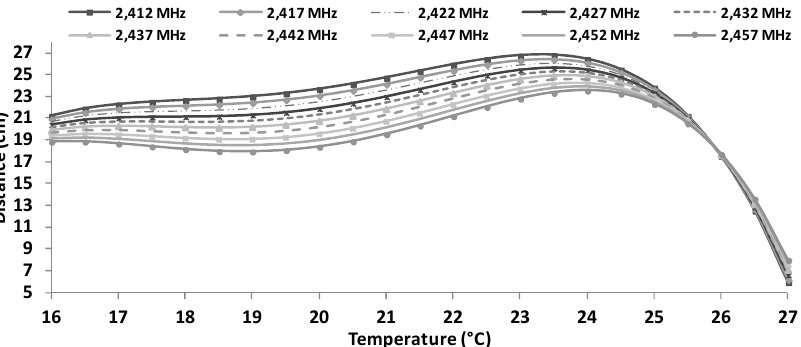
Figure 20. Estimated maximum distances for BPSK modulation.